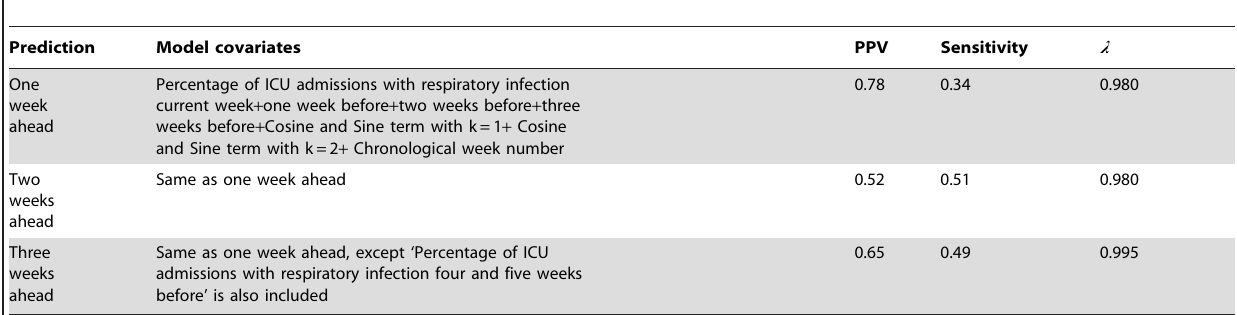
Table 3. GEE model covariates and decay factor l , giving historic data less weight, used for predicting one to three weeks ahead.